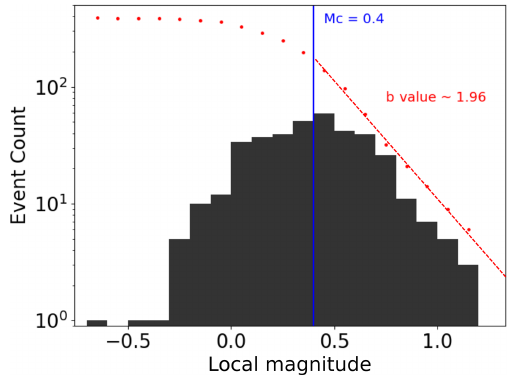
Figure 6. Frequency–magnitude distribution of events ( n = 389) detected in the KSMMA during quiescence from 28 March to 6 Au- gust 2020. Event counts in magnitude bins of 0.1 are shown as black columns; the cumulative event value per bin is shown as a red dot. The magnitude of completeness ( M c ) is 0.4 and the estimated b value is 1.96 (Gutenberg and Richter, 1944). Local magnitudes were calculated following Babaie-Mahani and Kao